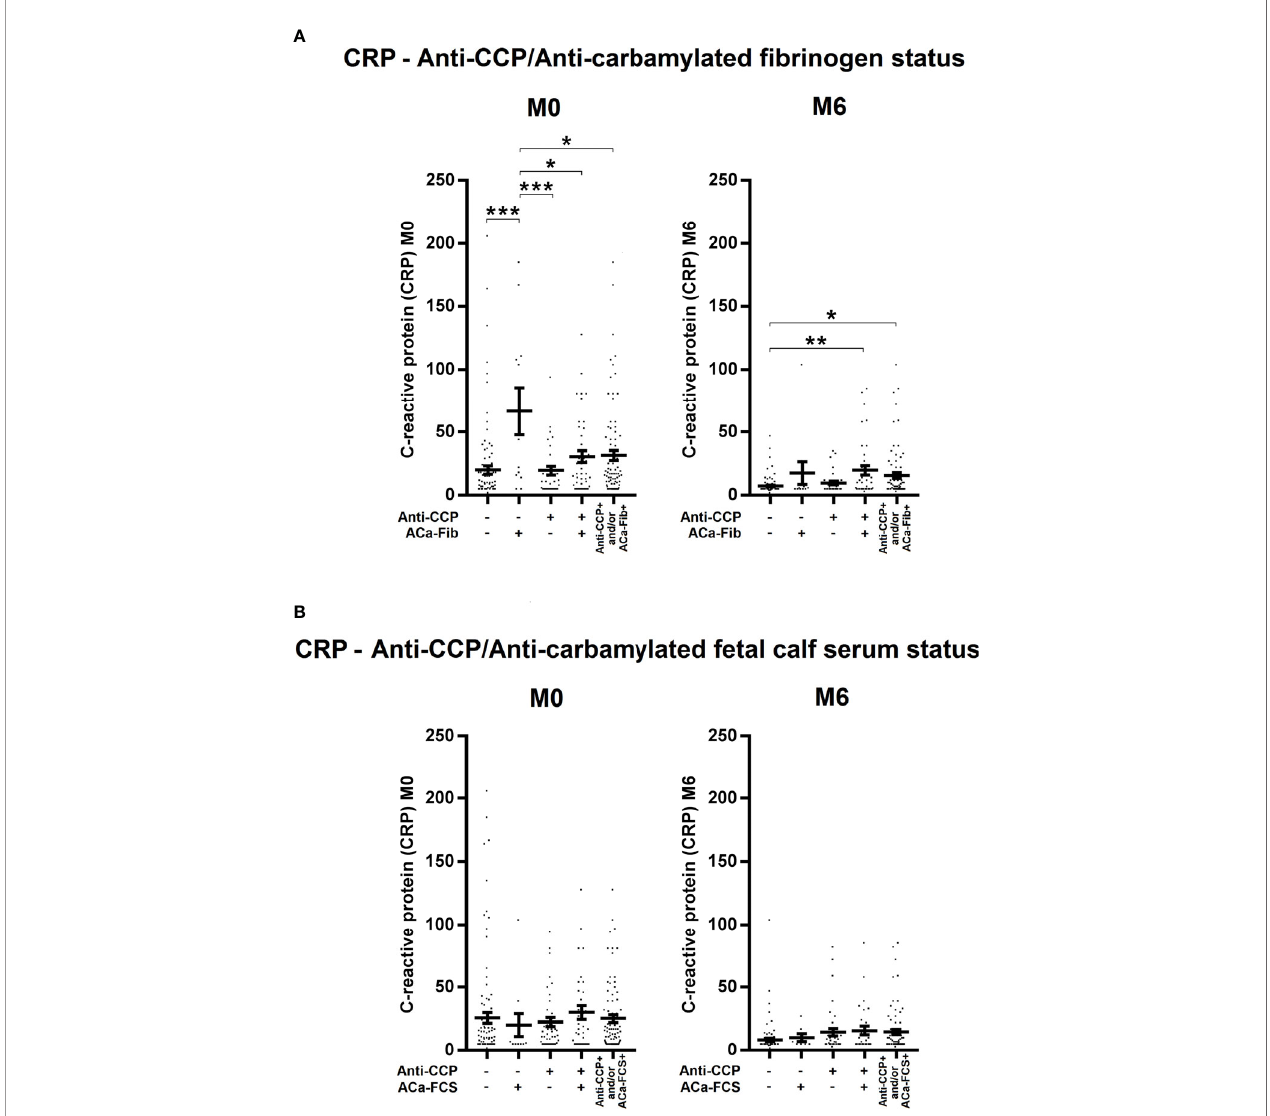
FIGURE 6 | Evolution of systemic in fl ammation of RA patients at baseline and 6 months according to anti-CCP antibodies and ACa-Fib or ACa-FCS status. C reactive protein (CRP) levels of RA patients according to (A) Anti-CCP/ACa-Fib status or (B) Anti-CCP/ACa-FCS status at baseline (M0), 6 months (M6), and 2 years (M24). Averages with SEM are shown. Groups were compared using one-way ANOVA and Tukey post-test, *p-value<0.05, **p-value<0.01, ***p-value<0.001. Anti- CCP, anti-cyclic citrullinated peptide antibodies; ACa-Fib, anti-carbamylated fi brinogen antibodies; ACa-FCS, anti-carbamylated fetal calf serum